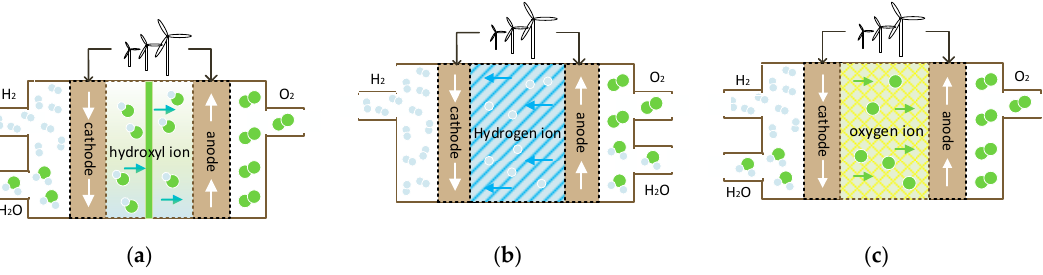
Figure 1. Diagrams of ( a ) alkaline electrolyzer, ( b ) Proton exchange membrane electrolyzer and ( c ) Solid oxide electrolyzer.